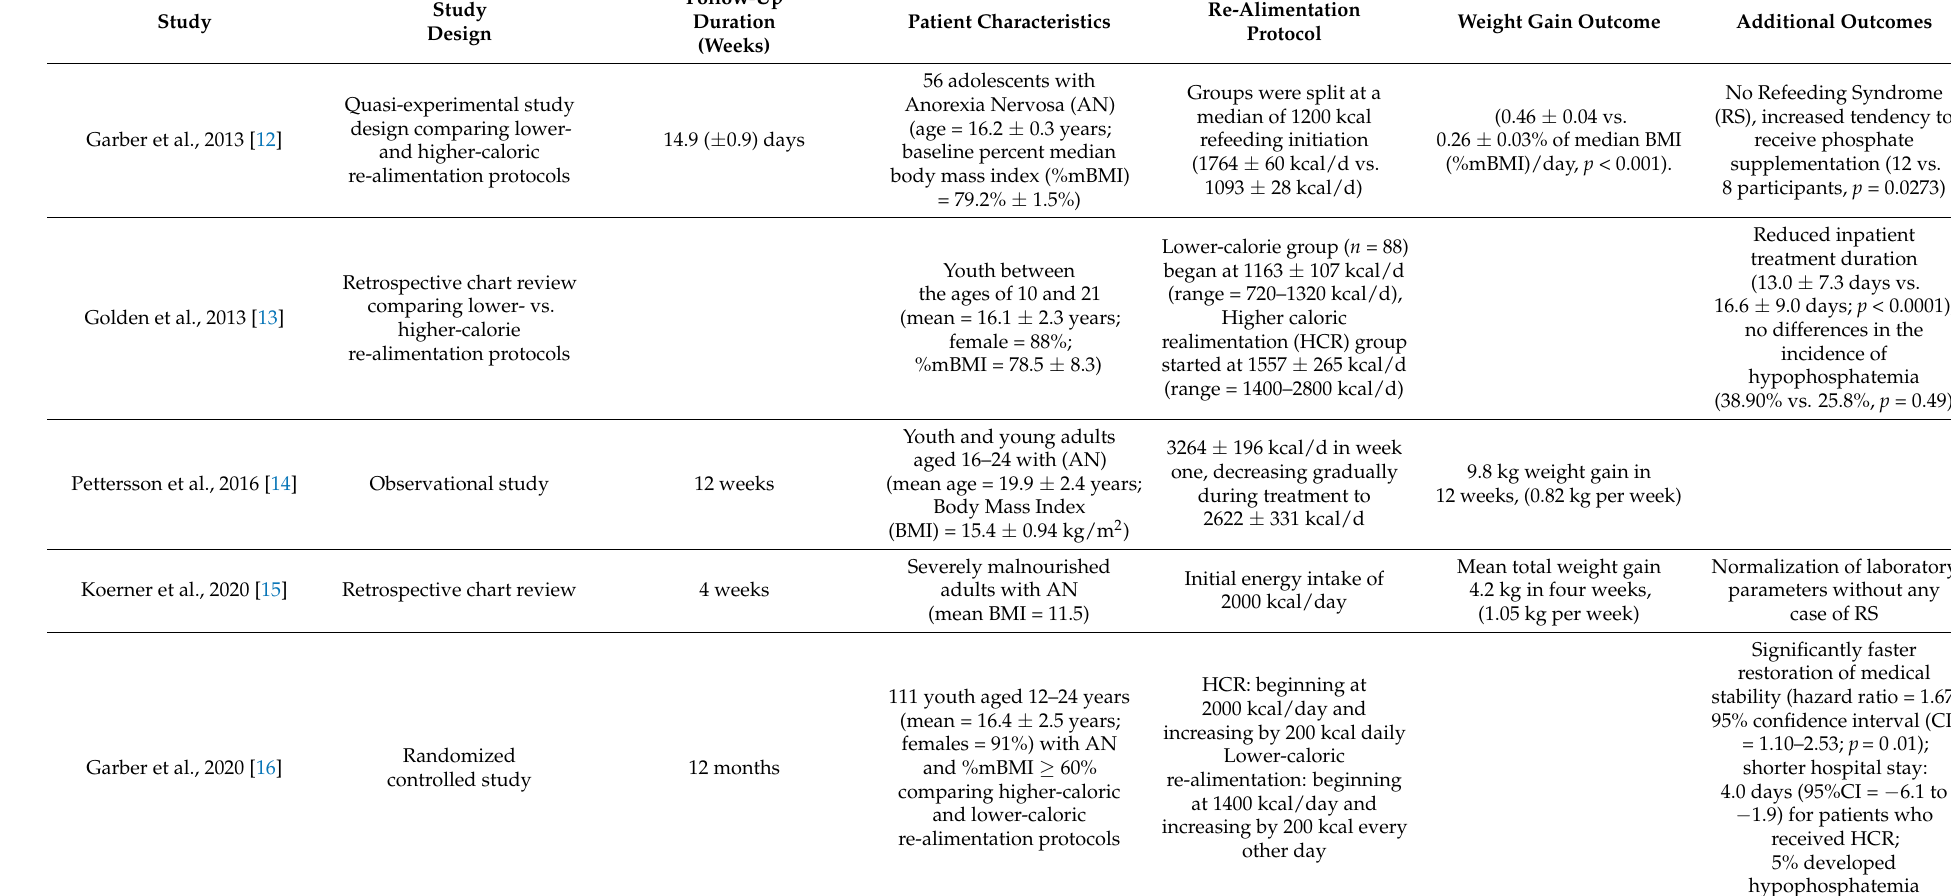
Table 1. Previous studies regarding the effect of higher-calorie re-alimentation approaches on weight gain and other